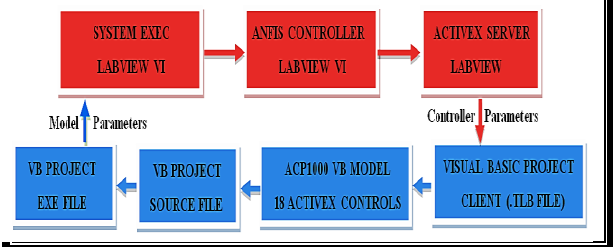
Design parameters of FO-MMF-VB